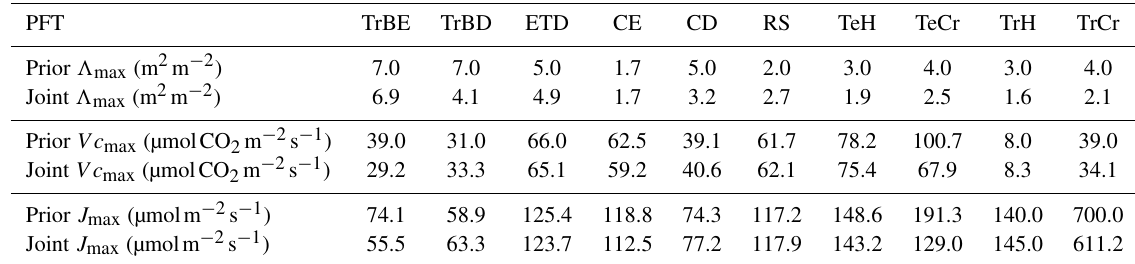
Table D1. Values of those parameters that have been changed with a multiplicative factor during the assimilation. PFT TrBE TrBD ETD